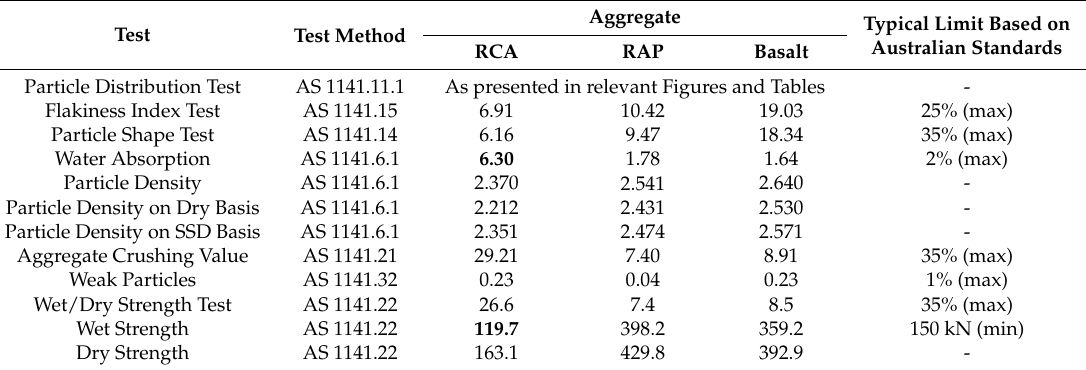
Table 10. Summary of the Test Results for the Evaluation of Coarse Aggregate Properties.